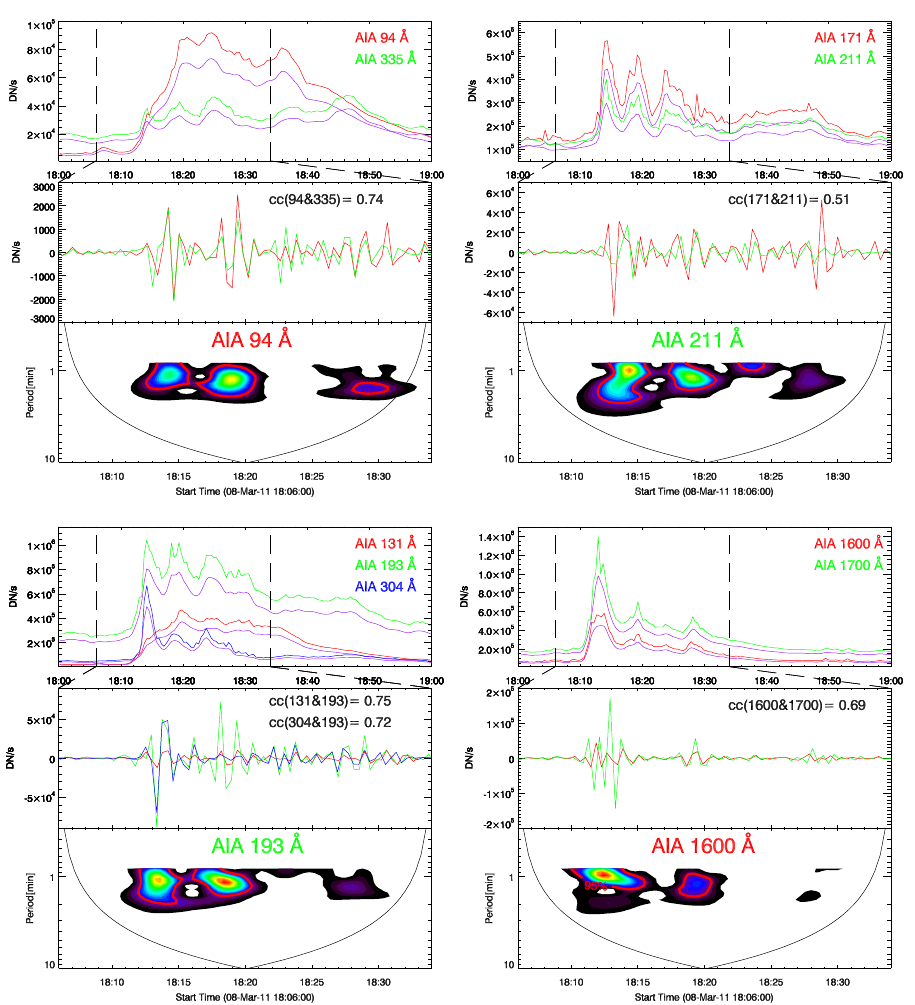
Figure 5. Similar to Figure 1, the light curves of nine AIA wavelengths, their slowly (purple curves, already multiplied by 0.8) and fast-varying components with their wavelet spectra. The correlation coefficient (cc) between the fast-varying components of different wavelengths are given. The red contours represent a significance level of